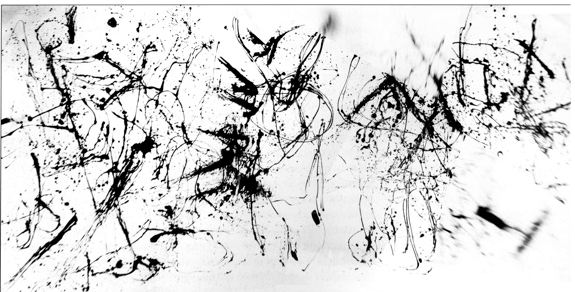
Figure 20. Autumn Rhythm in an intermediate state, after the completion of the configuration at the left end. Still photograph composite. © 2022 The Pollock-Krasner Foundation/Artists Rights Society (ARS), New York.